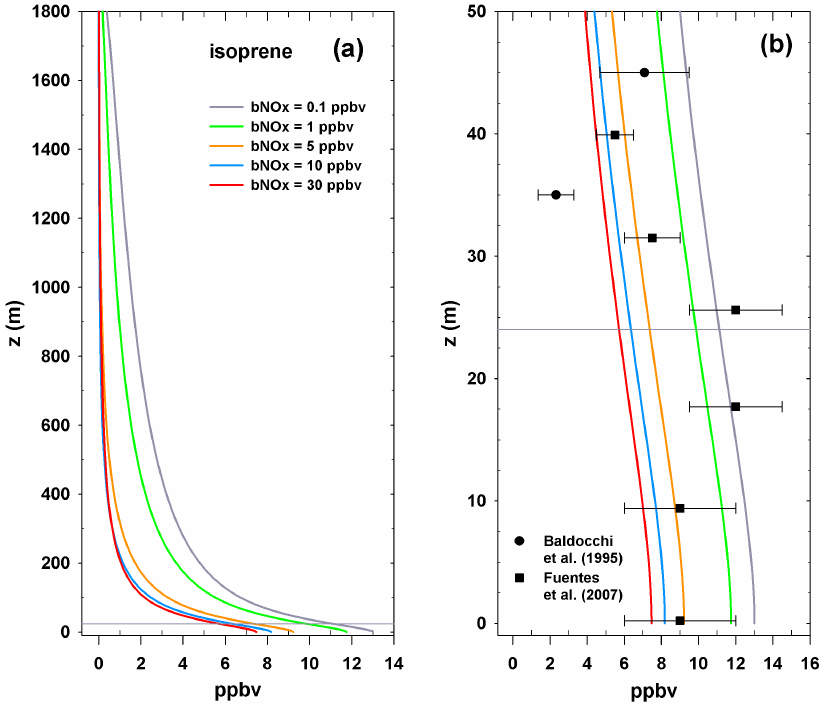
Fig. 7. Steady-state vertical profiles of isoprene (ppbv) for each background NO x value for (a) the entire column and for (b) the lowest 50m with measurements (means ± 1 standard deviation) of Baldocchi et al. (1995) and Fuentes et al. (2007) (horizontal gray line is canopy top